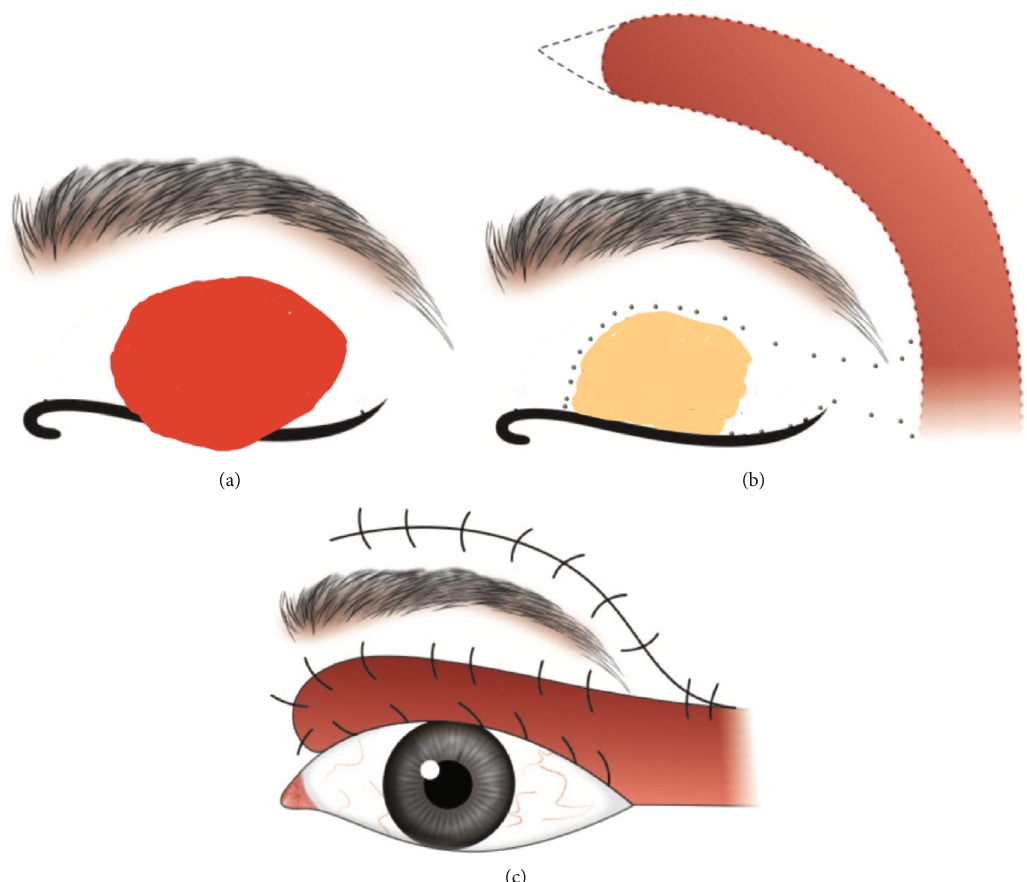
Figure 2: (a) A well-de fi ned mass seen on the left upper lid involving the lid margin. (b) After excision of the mass, the skin was undermined to decrease the size of the anterior lamellar defect and a lateral forehead rotational fl ap was raised. (c) The lateral forehead fl ap was mobilized to cover the defect, and the wound was closed without tension on suture